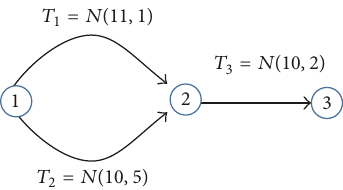
Figure 1: A paradoxical path